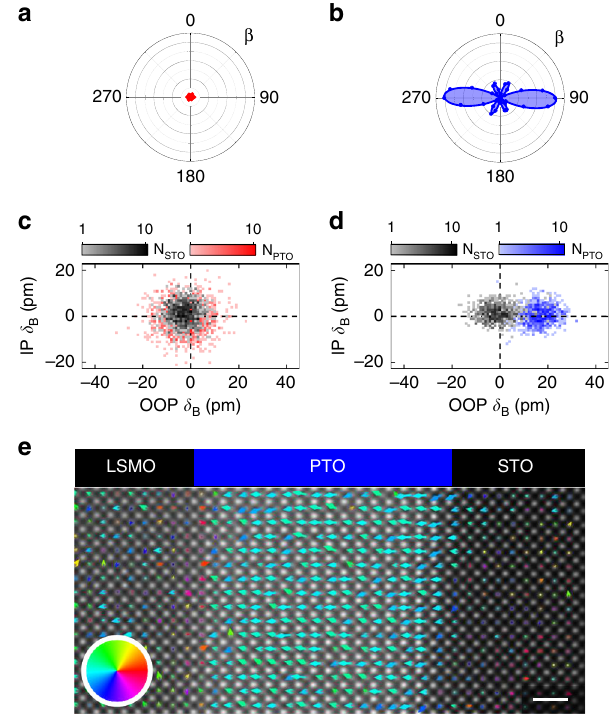
Fig. 5 Stability of net polarization in a STO ∣ PTO heterostructure. a , b SHG anisotropy plots of STO ∣ PTO bilayers after cooling to room temperature, shown on the same intensity scale. Data were obtained by simultaneously varying the angle β of the polarization of the incident fundamental and of the detected SHG light at 1200 and 600 nm, respectively. The simulations, see “ Methods, ” are plotted as continuous lines. Note that for the competitive interfaces ( a ), a measurable signal is not detected. c , d Logarithmic histogram plots showing the number of occurrences N STO (black) and N PTO of OOP and in-plane (IP) B-site displacement ( δ B ) measured in post-deposition STEM images for the ( c ) competitive (red) and the ( d ) cooperative (blue) interface con fi guration. The zero net value of B-site displacement in the OOP direction of the competitive case in the multidomain state is the result of polarization averaging across the thickness of the lamella. e Post-deposition STEM map of PTO dipole moments after STO capping in the cooperative con fi guration. The arrows show the direction (color wheel) and amplitude (arrow length) of the dipole moments. Scale bar is 1